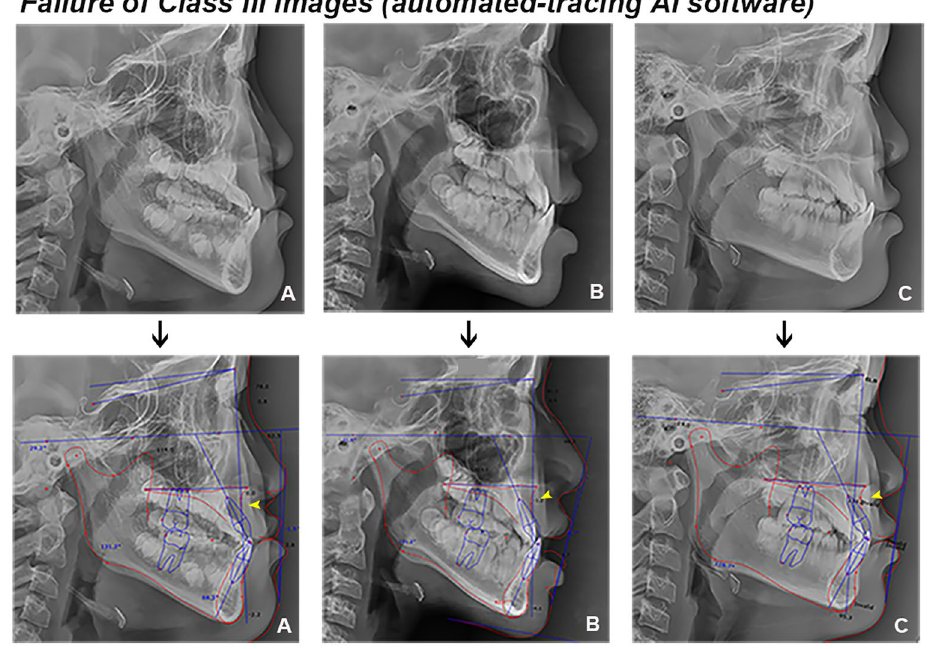
Figure 6. Examples of Class III images of automated-tracing AI software ( arrow , erroneous detection of